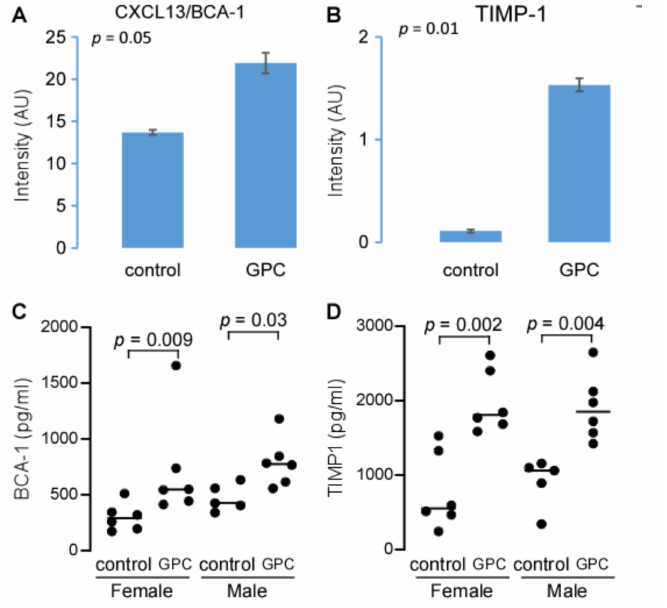
Figure 10. GPC increases expression of the pro-inflammatory chemokine CXCL13/BCA-1 and cytokine TIMP-1. ( A , B ) Comparison of plasma CXCL13/BCA-1 ( A ) and TIMP-1 ( B ) expression levels. Plasma was pooled from 10 female C57BL/6J LDLr − / − mice fed GPC supplemented chow diet, or 10 female mice fed control chow diet with 10 µ L plasma each mouse. CXCL13/BCA-1 ( A ) and TIMP-1 ( B ) were determined by Proteome Profiler TM Array using Mouse Cytokine Array Panel A kit. ( C , D ) BCA-1 and TIMP-1 concentrations in plasma were determined by ELISA. Each group contains 5 or 6 C57BL/6J LDLr − / − mice fed GPC supplemented chow diet or control chow diet, as indicated, for one month. p values in ( A , B ) were calculated by Student’s t test and in ( C , D ) by Wilcoxon rank sum